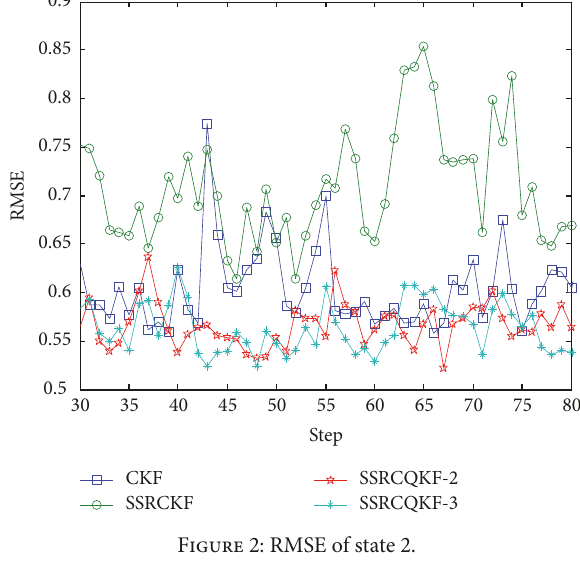
Figure 2: RMSE of state 2.